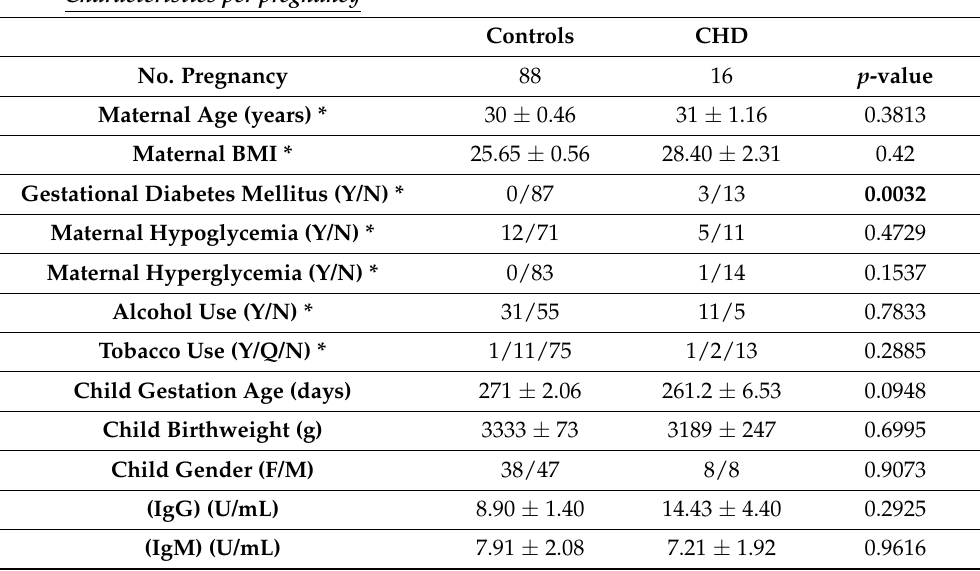
Table 1. Cont. Characteristics per